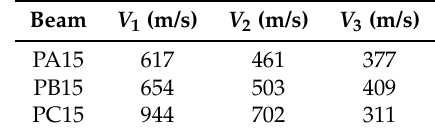
Table 8. Measured crack velocities along the first 51 mm of crack extension, using the technique of DIC for the beams impacted at 2.66 m/s.